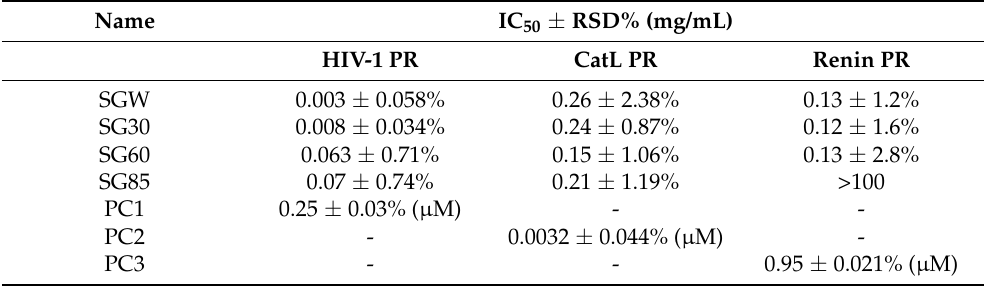
Table 1. The IC 50 values of SG extracts against HIV-1, Cat L, and renin PRs ( n =